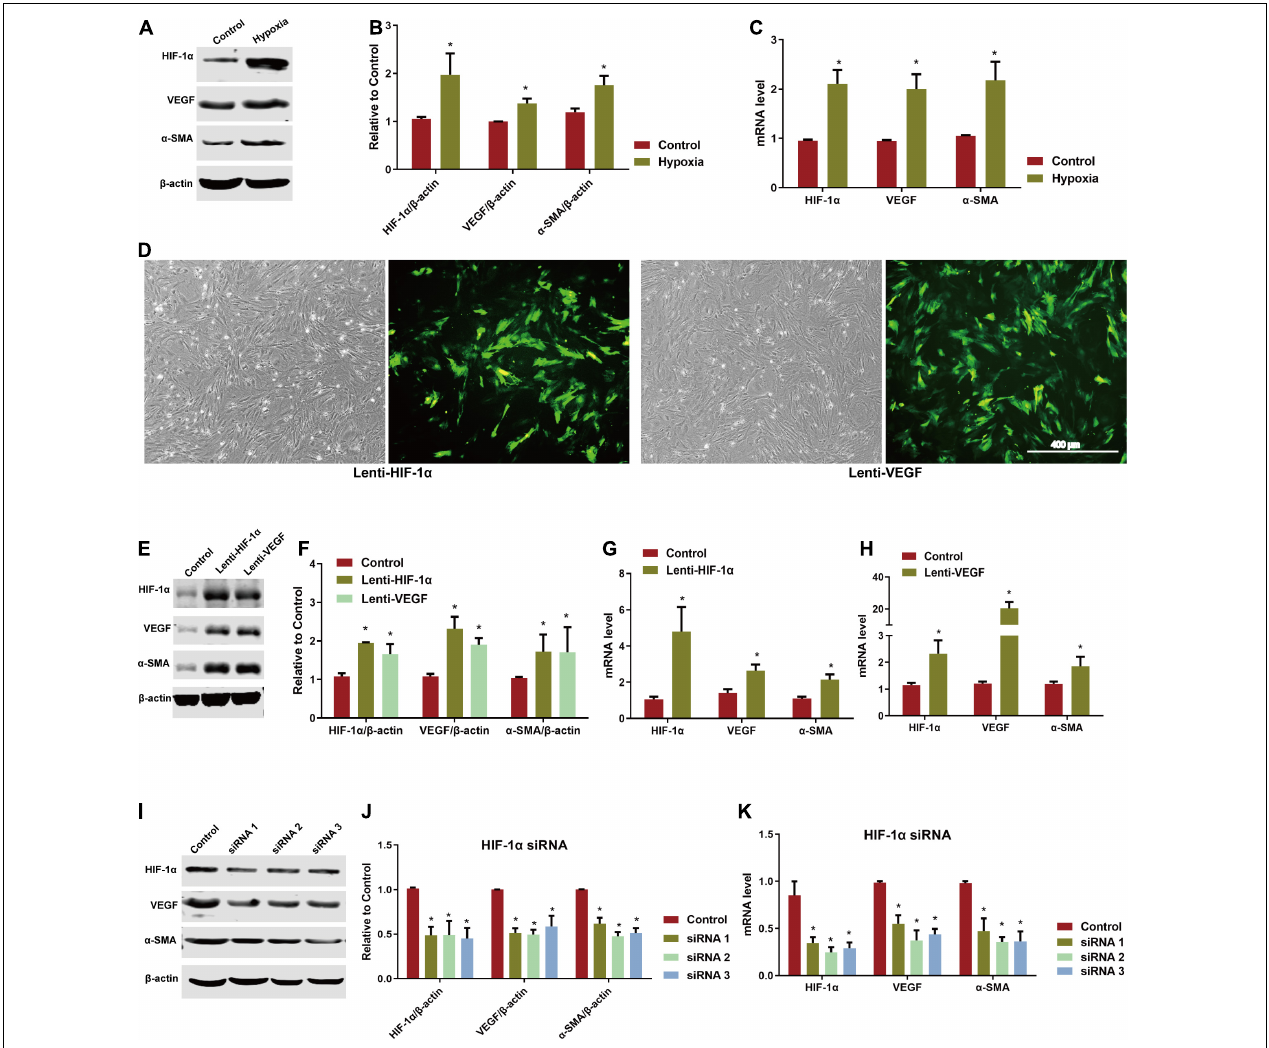
FIGURE 3 | Involvement of HIF-1 α /VEGF pathway in directed induction of endothelial differentiation of ADSCs. (A) Expression of HIF-1 α , VEGF, and α -SMA of hypoxia-induced ADSCs using western blotting. (B) Analysis of HIF-1 α , VEGF, and α -SMA by western blotting. * P < 0.05 vs. the control (normoxic) group. (C) mRNA level of hypoxia-induced HIF-1 α , VEGF, and α -SMA in ADSCs by RT-qPCR testing. * P < 0.05 vs. the control (normoxic) group. (D) ADSCs transfected by lenti-HIF-1 α and lenti-VEGF for 72 h (Scale bar = 400 µ m). (E,F) Expression and analysis of HIF-1 α , VEGF, and α -SMA of lenti-HIF-1 α and lenti-VEGF transfected ADSCs by western blotting. * P < 0.05 vs. the control (blank vector) group. (G,H) mRNA levels of HIF-1 α , VEGF, and α -SMA of lenti-HIF-1 α and lenti-VEGF transfected ADSCs by RT-qPCR testing. * P < 0.05 vs. the control (blank vector) group. (I,J) Expression and analysis of HIF-1 α , VEGF, and α -SMA of ADSCs knocked down by HIF-1 α siRNA detected by western blotting. * P < 0.05 vs. the control (negative) group. (K) mRNA levels of HIF-1 α , VEGF, and α -SMA of ADSCs knocked down by HIF-1 α siRNA detected using RT-qPCR. * P < 0.05 vs. the control (negative)